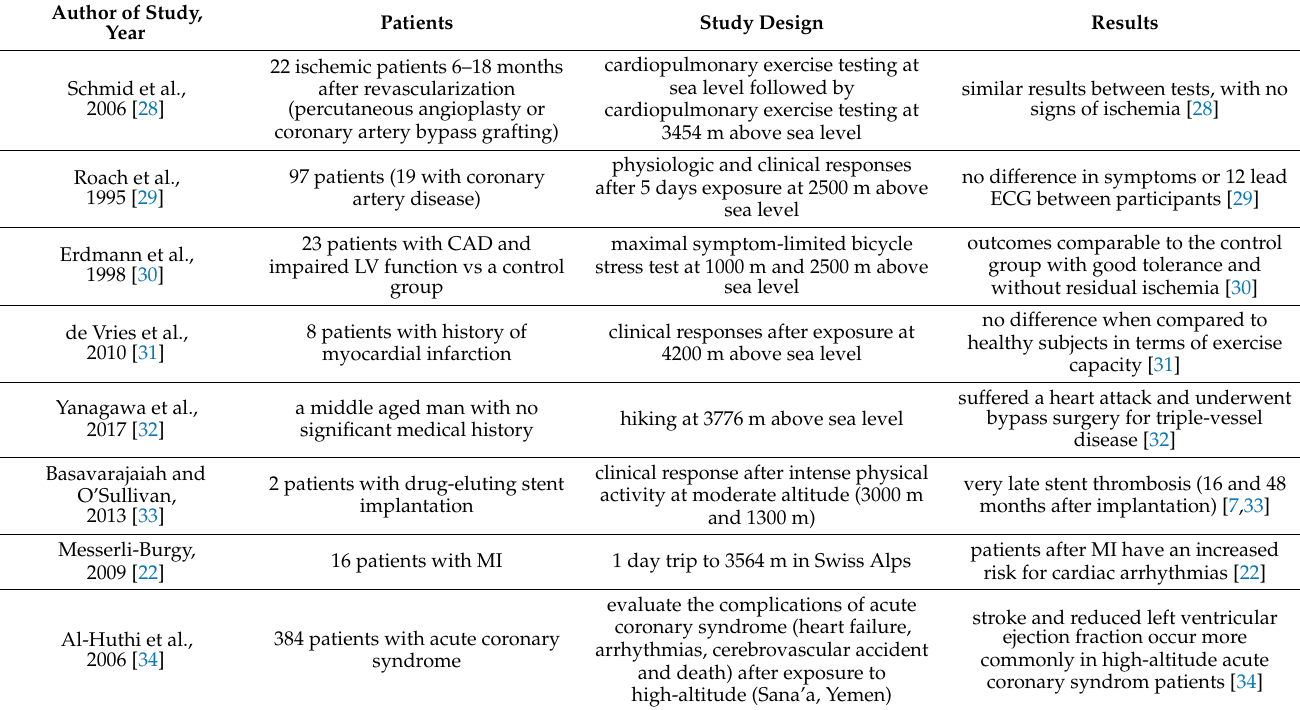
Table 3. Summary of high-altitude exposure on CAD